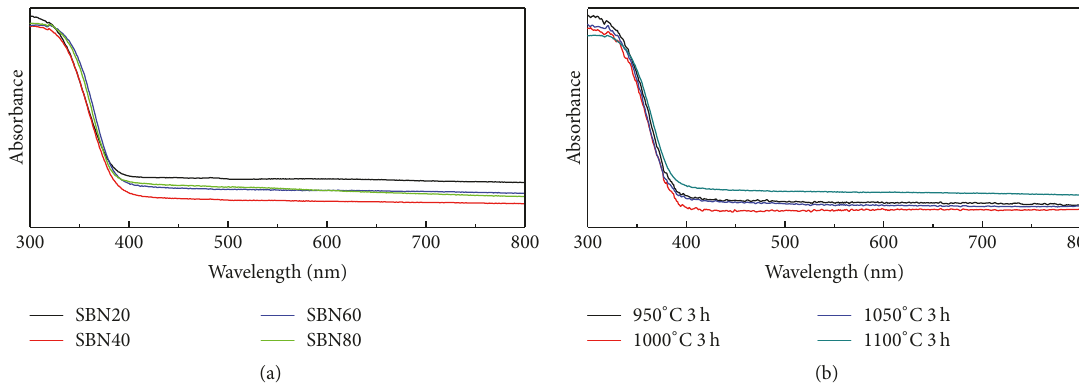
Figure 5: The UV-vis absorption spectra of the flux-synthesized SBN nanocrystals: (a) with different components; (b) at different reaction temperatures.